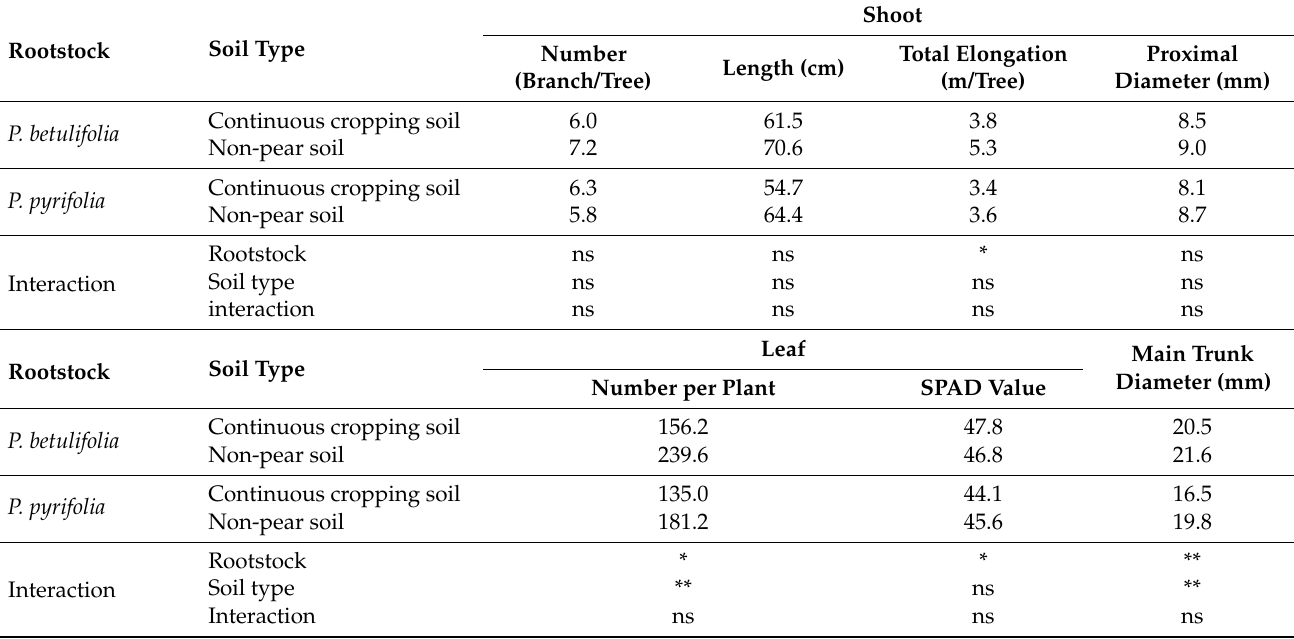
Table 6. Difference between rootstock and soil on growth of